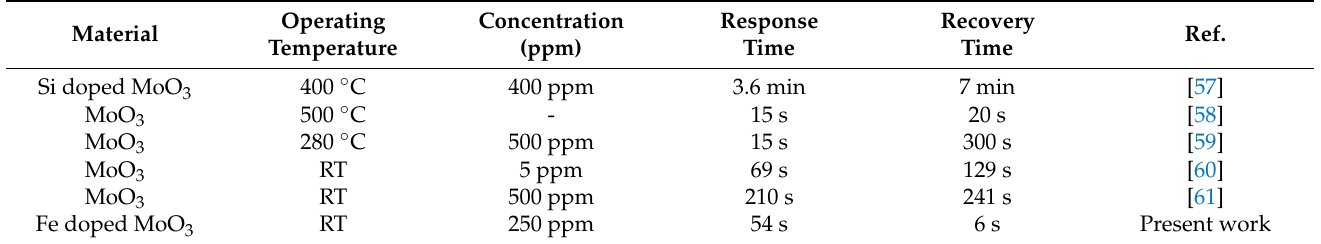
Table 3. Comparison of ammonia sensing performances of Fe doped MoO 3 thin films with other MoO 3 based